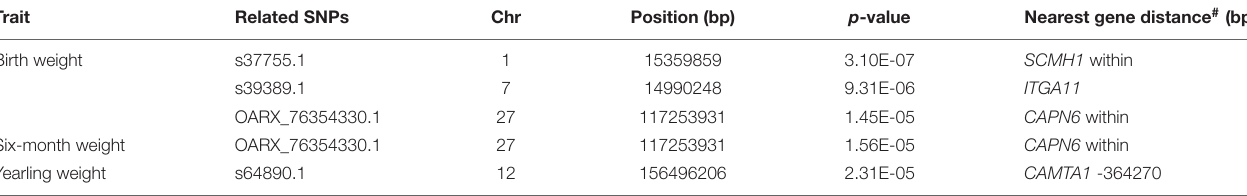
TABLE 1 | Analysis of related SNPs associated with birth weight of Hu sheep. Trait